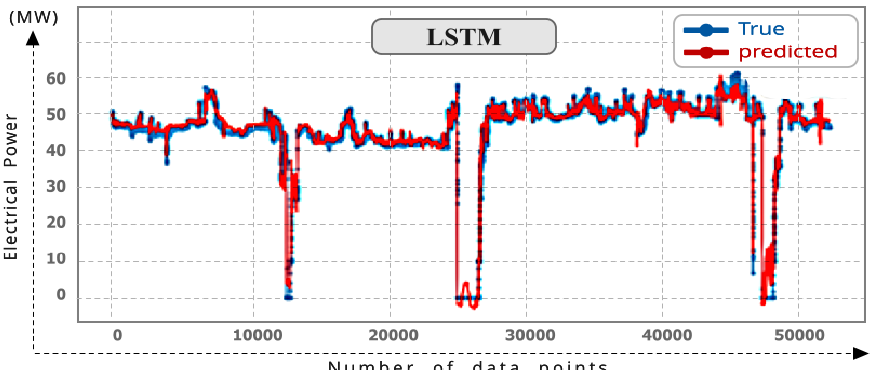
Figure 5. LSTM prediction results versus actual results.